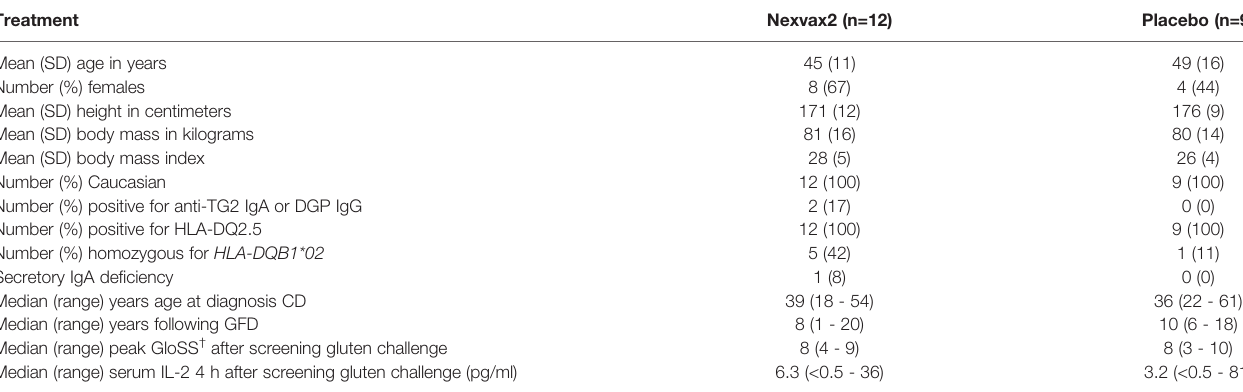
TABLE 3 | Demographics and characteristics of RESET CeD Study participants. Treatment